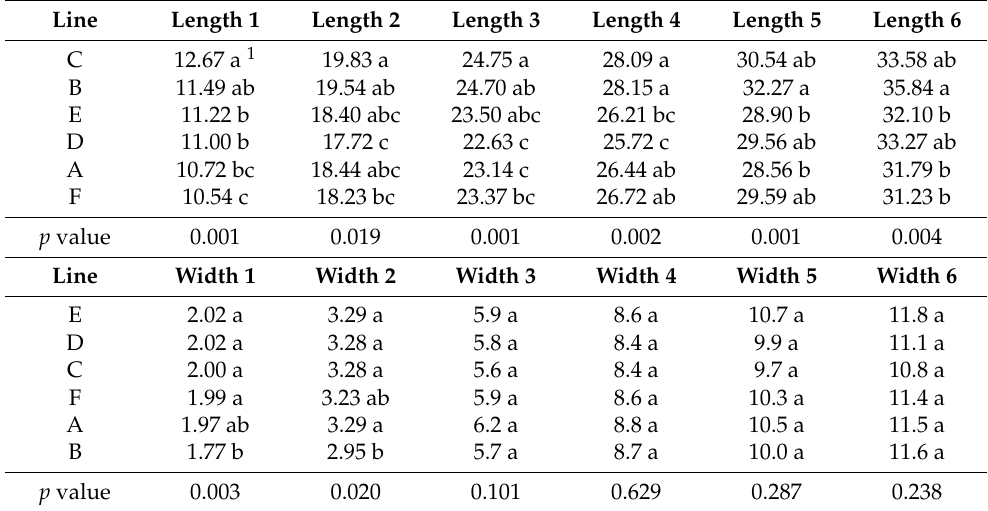
Table 4. Leaf blade length (cm) and width at midpoint (mm) for the first six leaves on the main stem for intermediate wheatgrass lines over four growth room